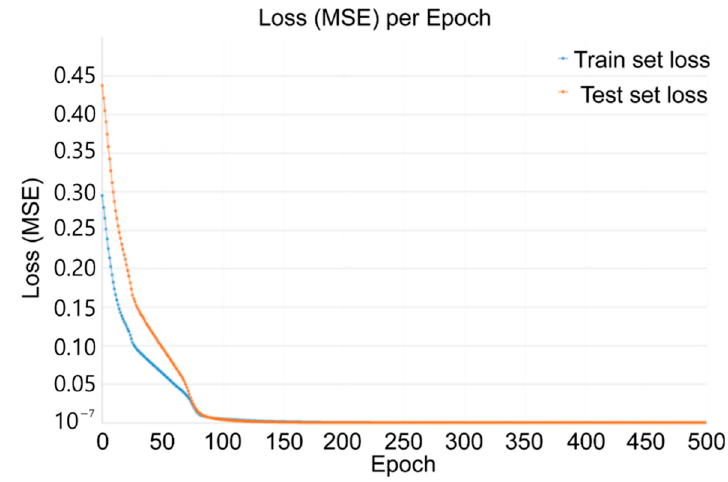
Figure 7. Mean square error (MSE) of the hole size prediction data.